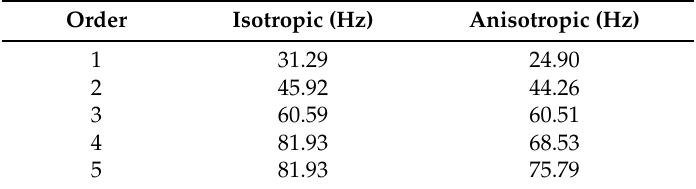
Figure 7. Comparisons of free mode shapes between the isotropic and the anisotropic plates. Table 2. Comparisons of free modal frequencies between the isotropic and the anisotropic plates. Order Isotropic